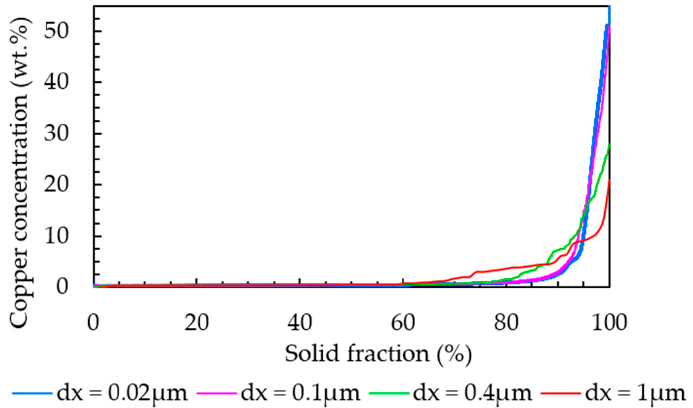
Figure 14. Sorted copper concentration values from phase ‐ field simulations for an Al ‐ 2.63Cu ‐ 1.56Li droplet evaluated with different grid resolutions.